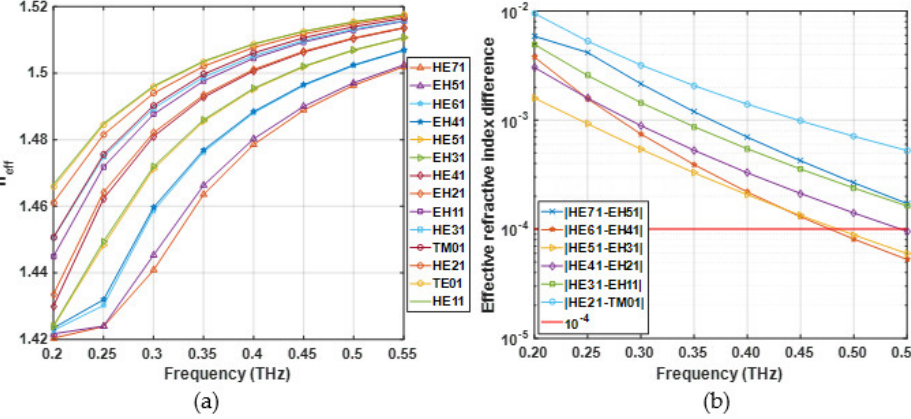
Figure 8. ( a ) The effective refractive index as a function of the frequency for different vector modes. ( b ) The effective refractive index difference as a function of the frequency for EH and HE modes.